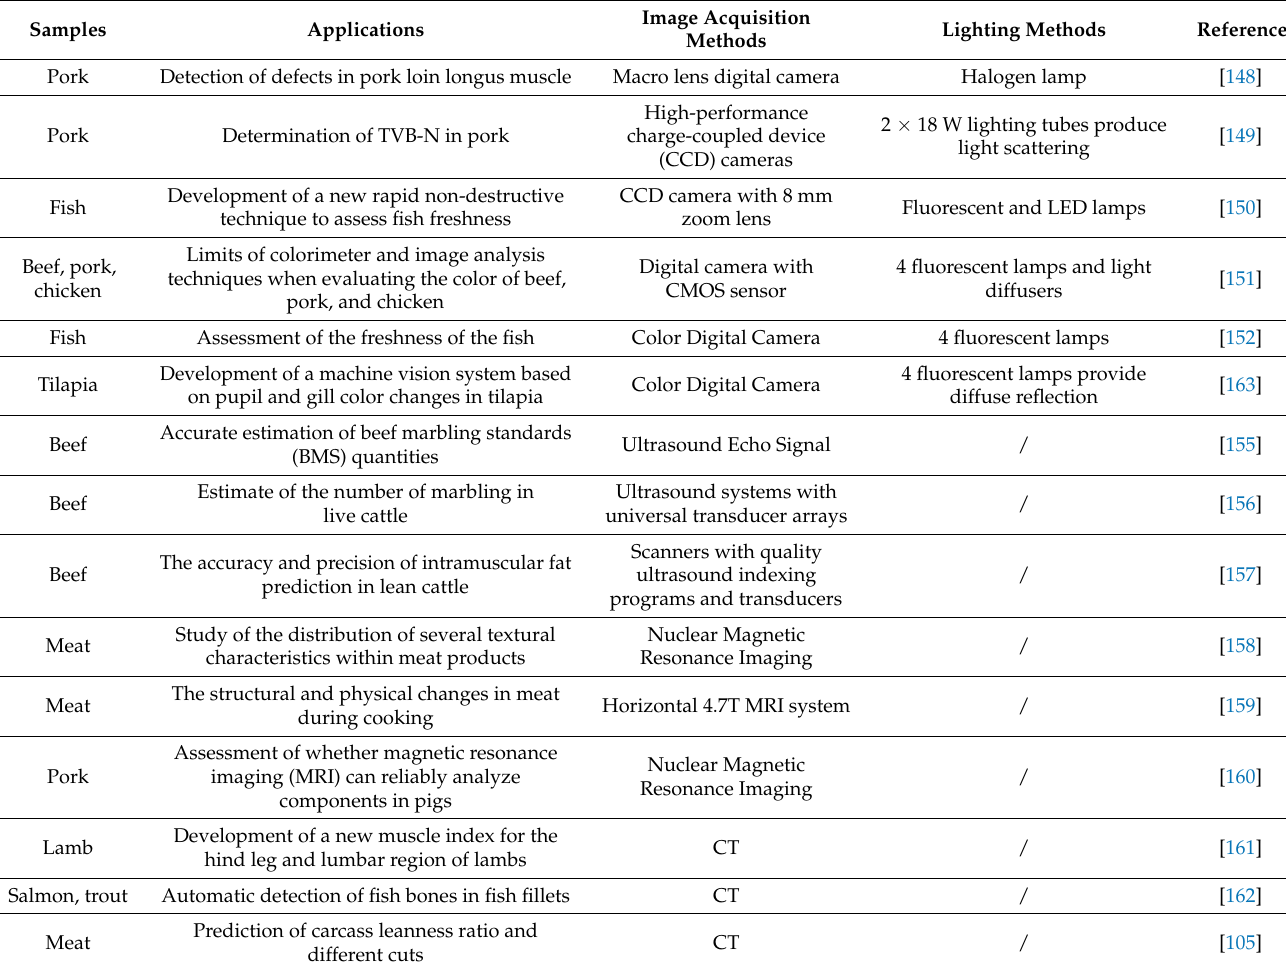
Table 3. Summaries of different illumination and image acquisition methods in machine vision systems applied for meat